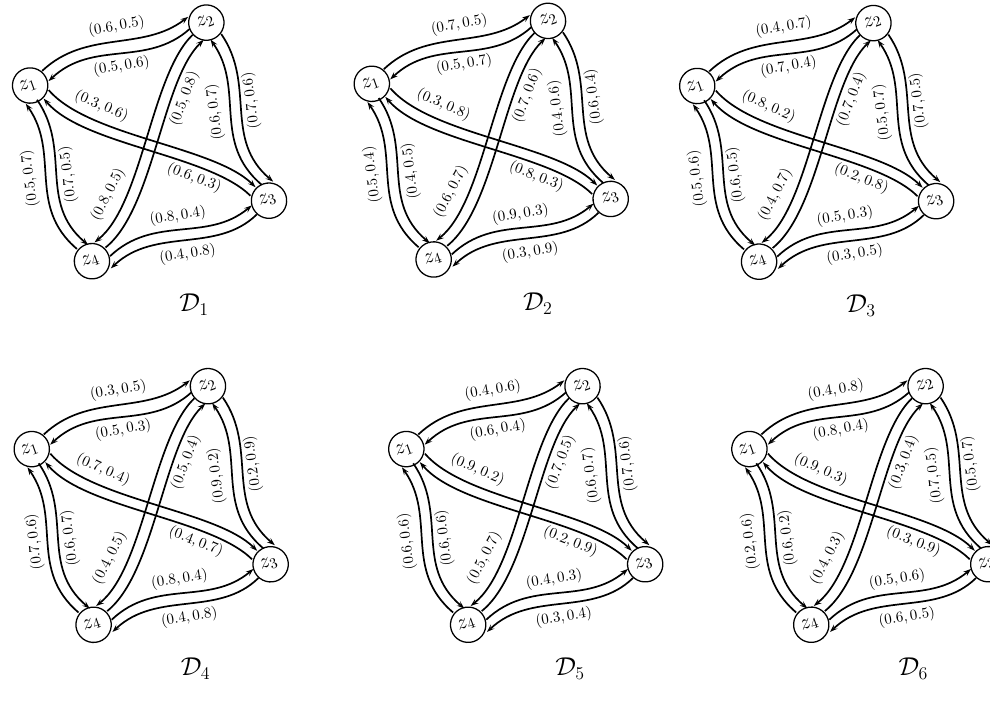
Figure 6. Pythagorean fuzzy